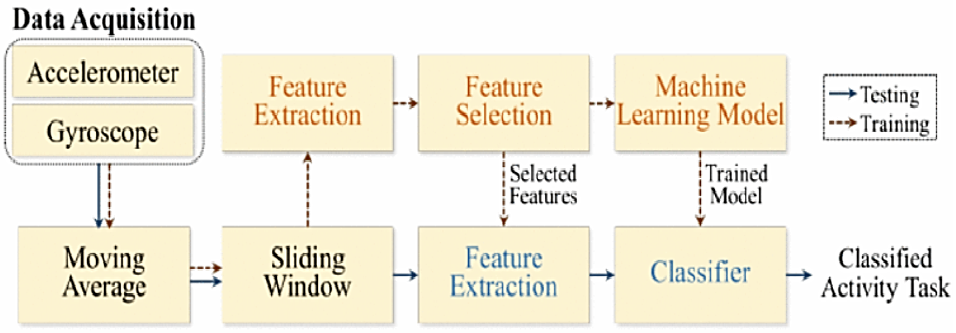
Figure 25. Architecture of the proposed housekeeping task monitoring system [91] (Reprinted with permission from ref. [91]. Copyright 2021 IEEE).